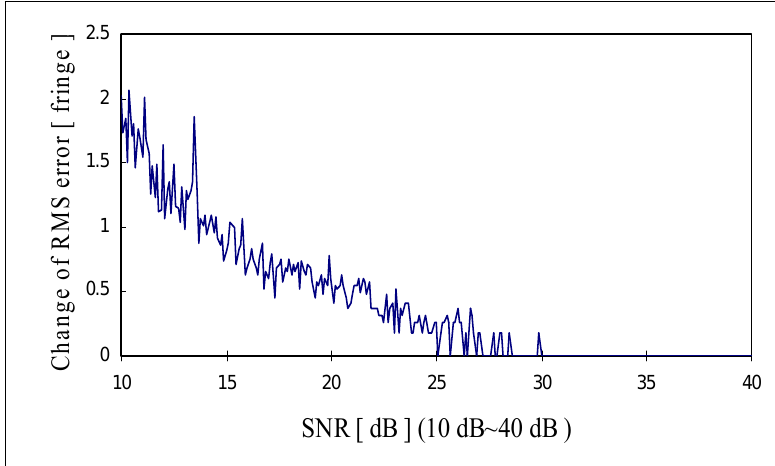
Figure 11 . Change of RMS error as a function of SNR (10~40